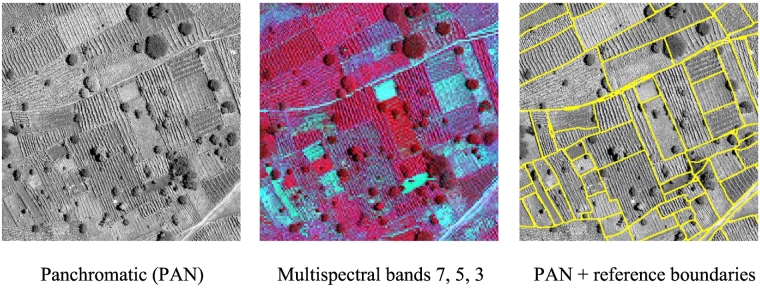
– Subset of a WorldView-3 image acquired over Kofa, Nigeria.